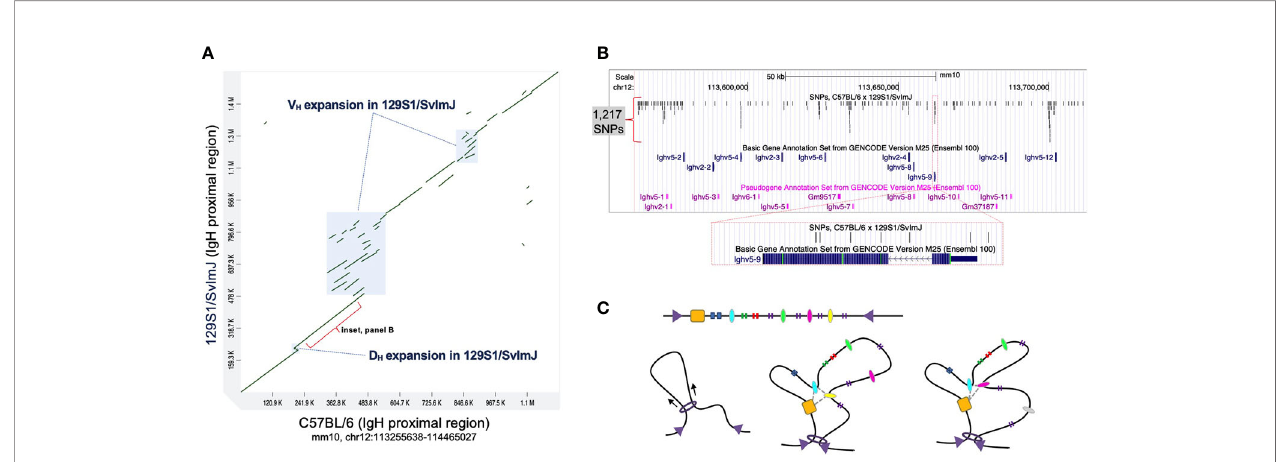
FIGURE 2 | Comparison of the C57BL/6 and 129S1/SvlmJ Igh loci reveals signi fi cant polymorphisms. (A) A dot plot representing a sequence comparison of the proximal region of IgH (mm10, chr12:113255638-114465027) between the mouse strains 129S1/SvlmJ and C57BL/6; sequences from each strain were compared using MashMap (64, 65). Annotated boxes represent regions of complex structural variants, in which Ig gene segments vary in copy number between the two strains. Sequence identities within homologous regions (green diagonal lines) range between 84% and 98%. (B) A map of a 150 Kb region within the Igh proximal region (mm10, chr12:113562489-113712488). Shown are the positions of functional Ighv genes and pseudogenes, and single nucleotide polymorphisms (SNPs; indels not included) that differentiate the 129S1/SvlmJ and C57BL/6 haplotypes. In total, 1,217 SNPs are present, including variants in both coding and non-coding sequences, as illustrated in the inset panel centered on the functional gene Ighv5-9. SNPs in this region were identi fi ed by mapping the corresponding Igh sequence from 129S1/SvlmJ to mm10 using BLASR. (C) Top: Linear sequence of a chromatin neighborhood fl anked by converging CTCF sites (purple triangles). Regulatory elements (ovals) and gene elements (vertical bars) are dispersed throughout the neighborhood. Left: Cohesin (ring) reels the chromatin fi ber in to extrude a loop, facilitating interactions between regulatory elements. Middle: A promoter-enhancer interactome (gray dashed line) can confer locus structure with a distinct set of interactions. Right: Loss of association with the interactome results in topological changes and affects access to genetic